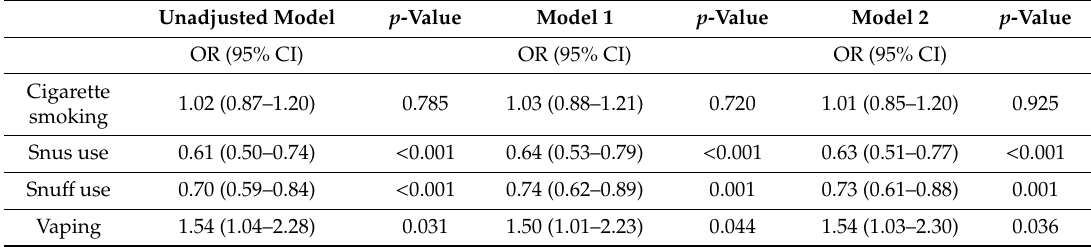
Table 4. Association between tobacco or nicotine use and individual sport (vs team